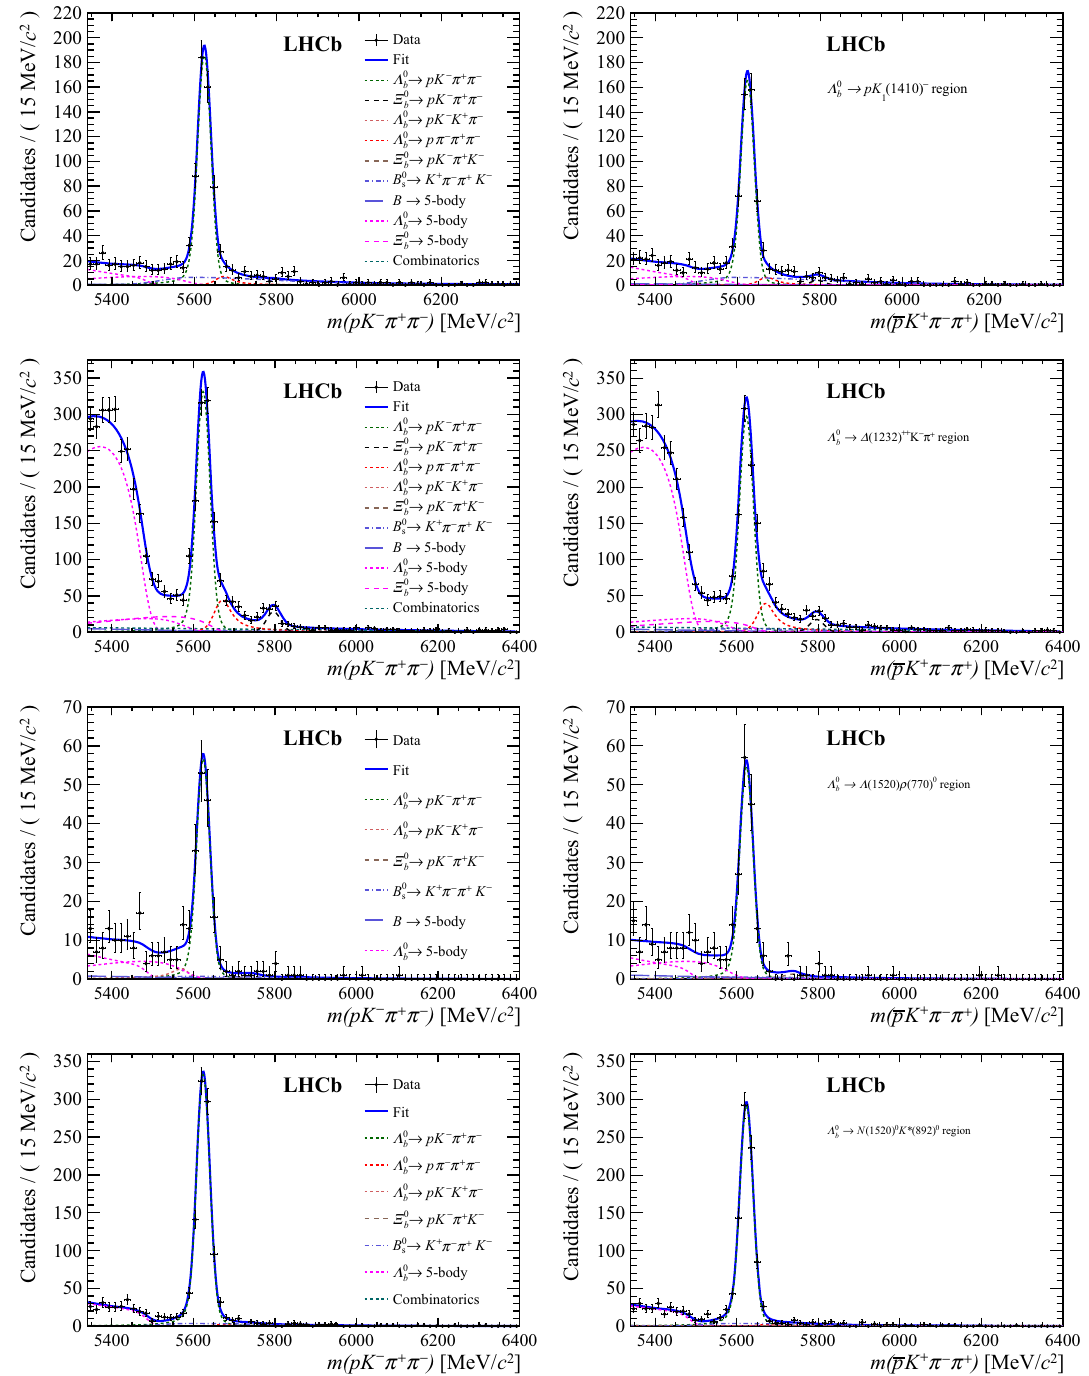
Fig. 5 Invariant pK − π + π − distributions, with the results of the N ( 1520 ) 0 K ∗ ( 892 ) 0 quasi two-body decays. The two columns cor- fit superimposed: region of the phase space containing (first row) respond to the charge-conjugate final states: (left) baryon, (right) Λ 0 → pK ( 1410 ) − , (second row) Λ 0 → Δ( 1232 ) ++ K − π − , antibaryon. The different components employed in the fit are indicated 1 b b → Λ( 1520 )ρ( 770 ) 0 and (last row) Λ 0 → in the (third row) Λ 0 b b